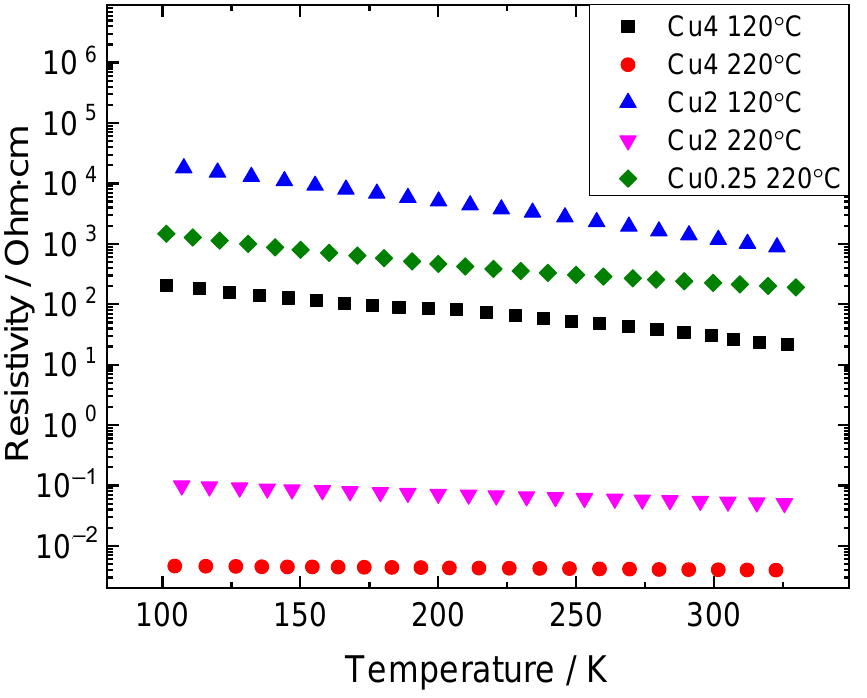
Figure 8. Temperature dependence of the resistivity of the initial (i.e., dried at 120 °C) and annealed at 220 °C in air CZTS NC thin films with various Cu contents.